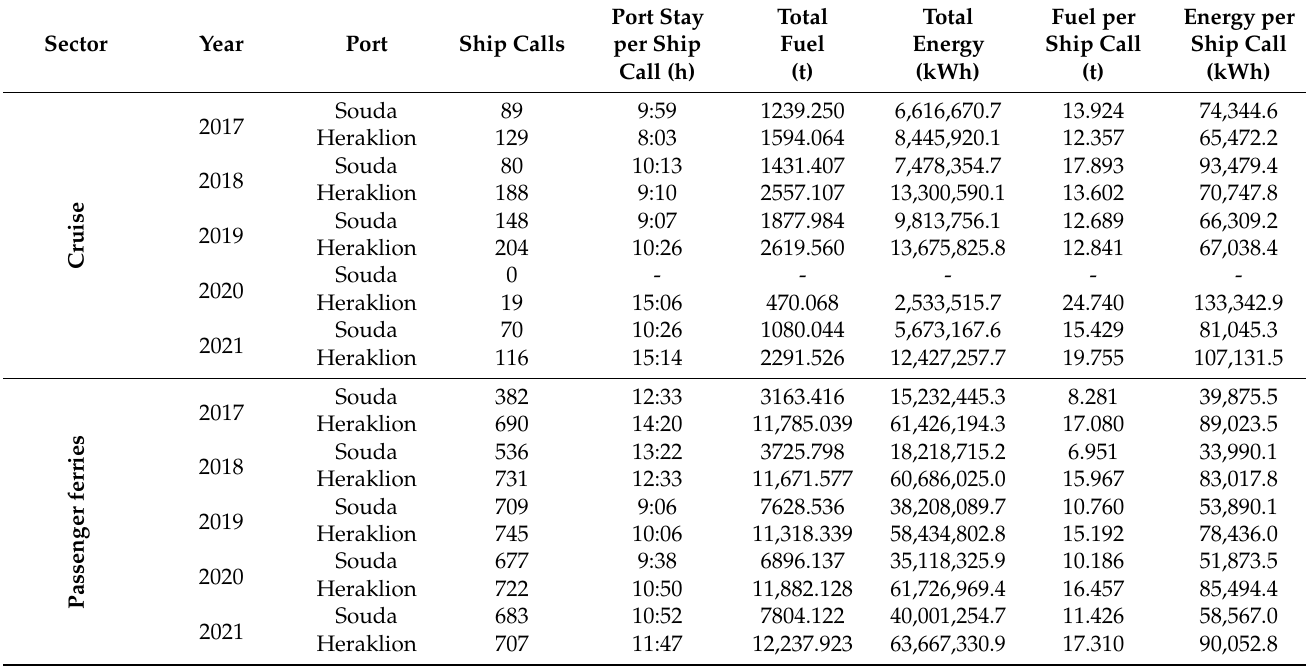
Table 2. Cruise and passenger ferries fuel and energy consumption.